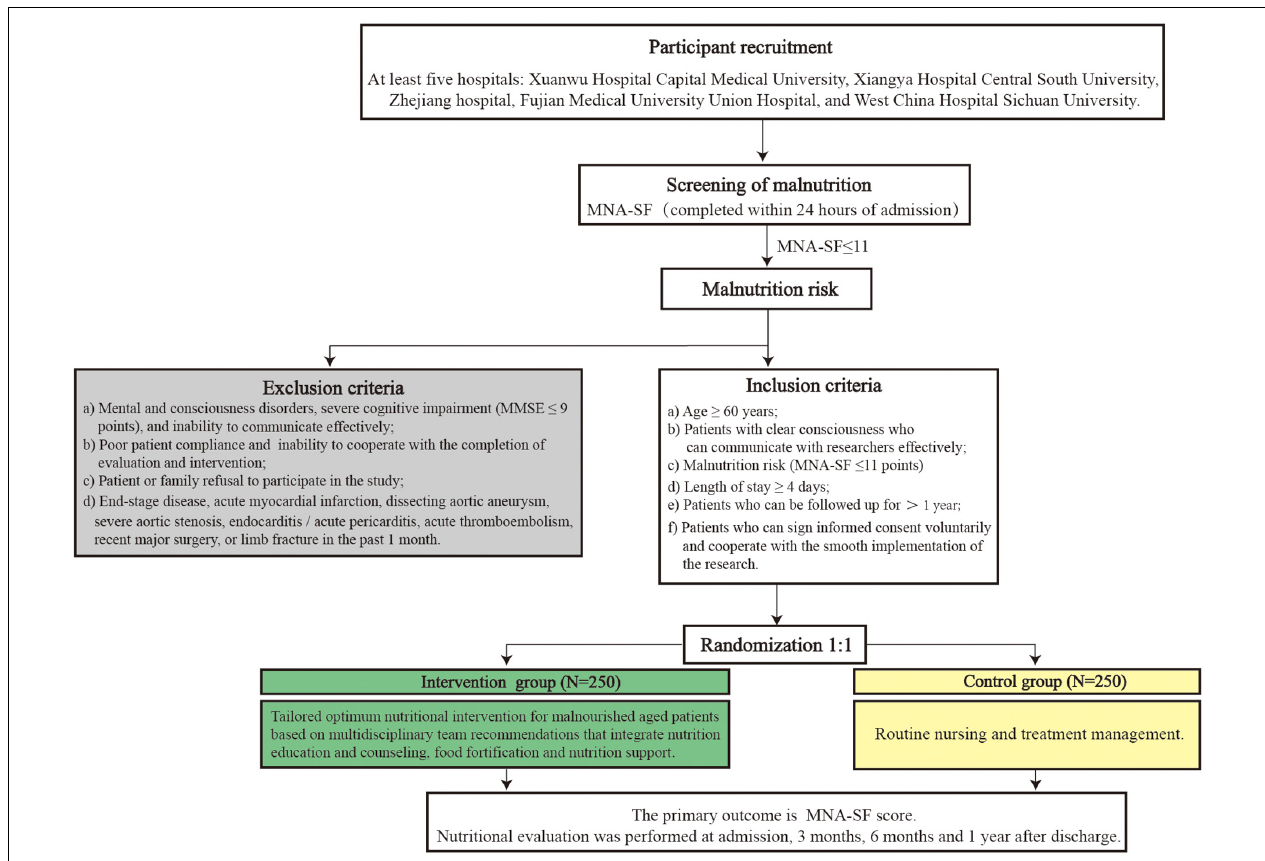
FIGURE 1 | Flow diagram of the study. MNA-SF, Mini Nutritional Assessment Short